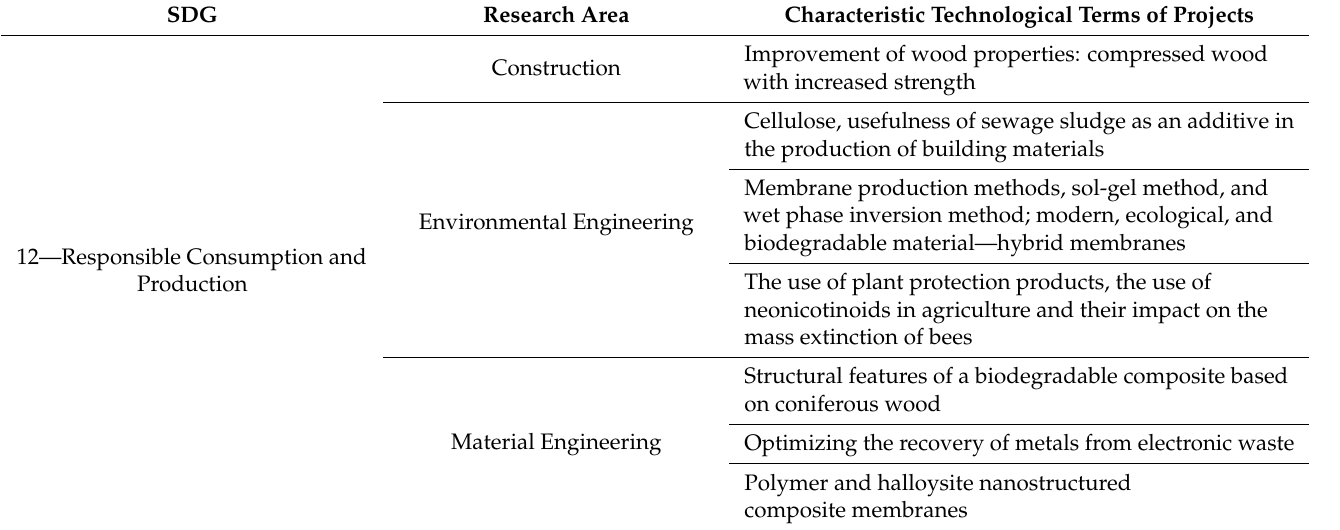
Table 9. Characteristic technological terms of projects for Responsible Consumption and Production.